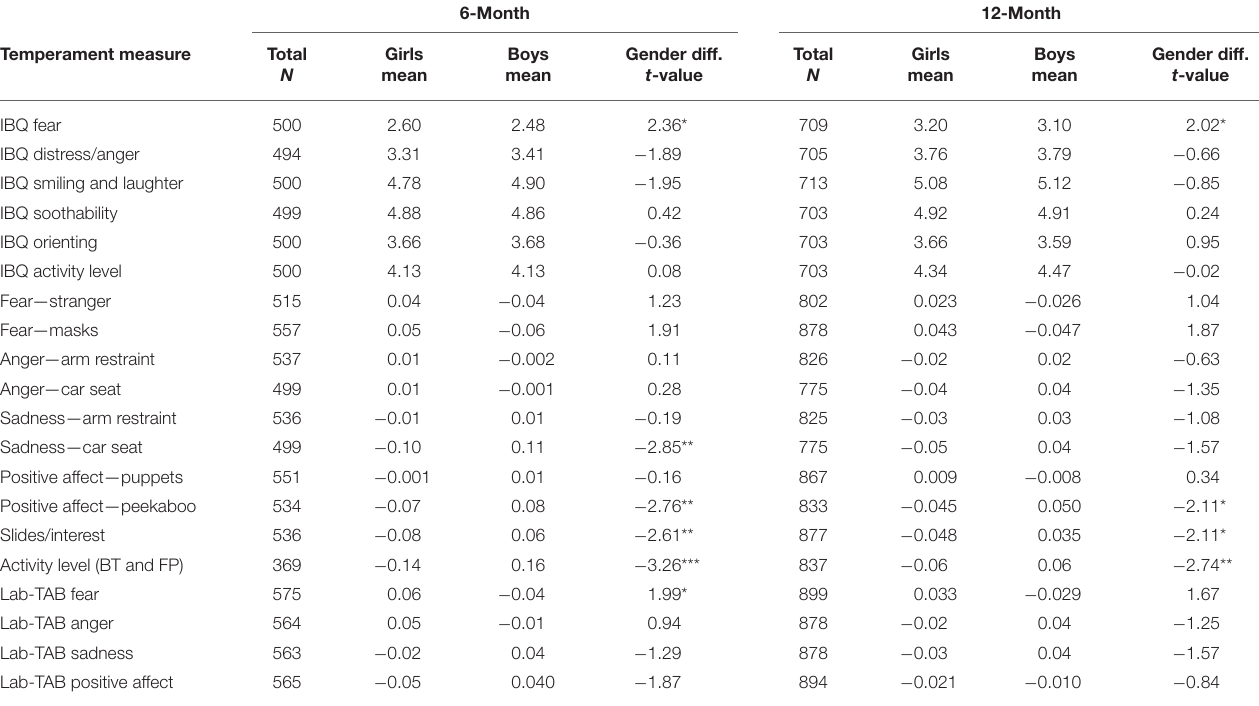
TABLE 5 | Means, standard deviations, and gender comparisons for infant temperament measures. 6-Month 12-Month Temperament measure Gender diff. Gender diff.